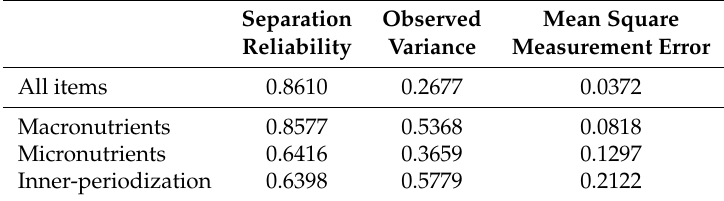
Table 5. Fitting results for the rating scales model. Higher separation reliability values represent better model fitting and a reliability below 0.50 indicates that the differences between measures are mainly due to measurement error. A single global model explains the data better than multiple sectional